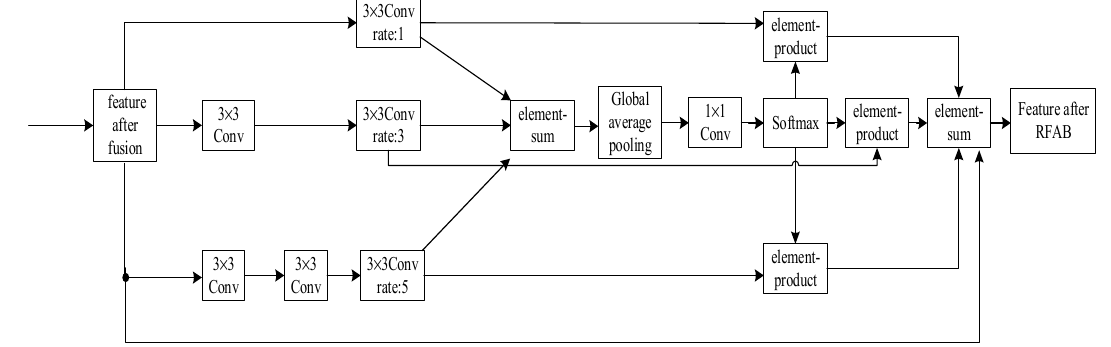
Figure 4. Structure of receptive field adaptation block (RFAB).